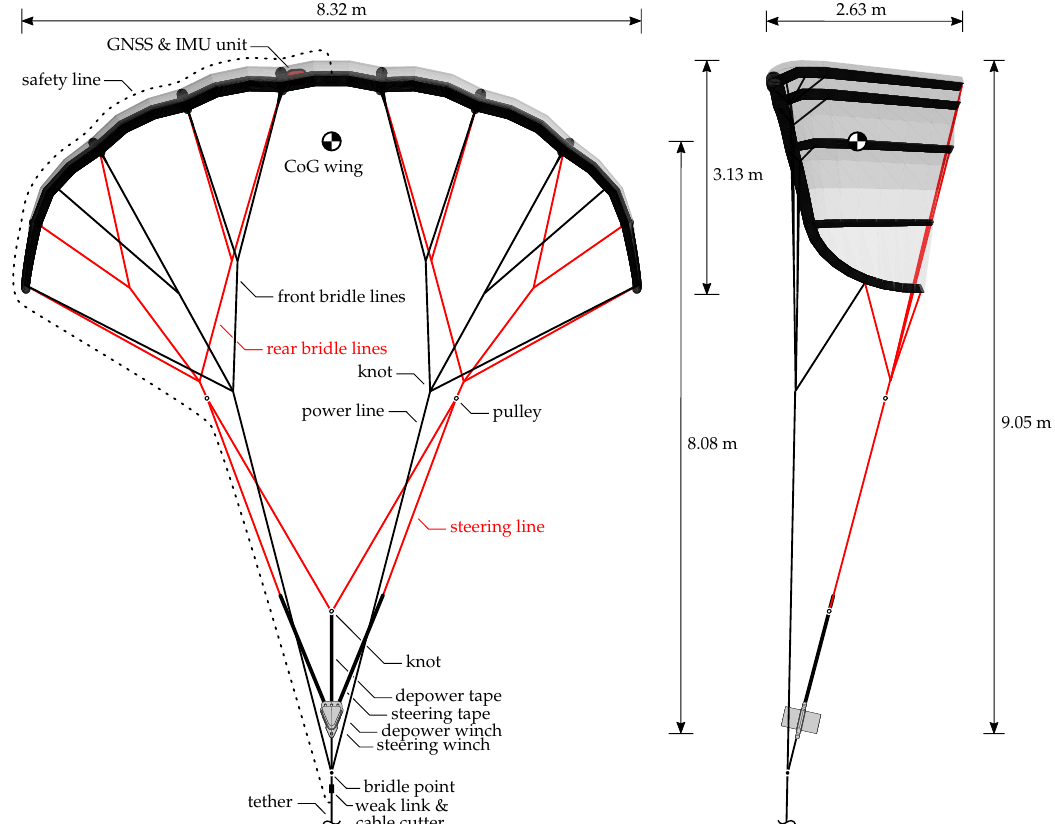
Figure 25. TU Delft V3 kite in front (left) and side view (right) [38]. KCU is displayed without the exterior foam shell and the attached small wind turbine for supplying onboard